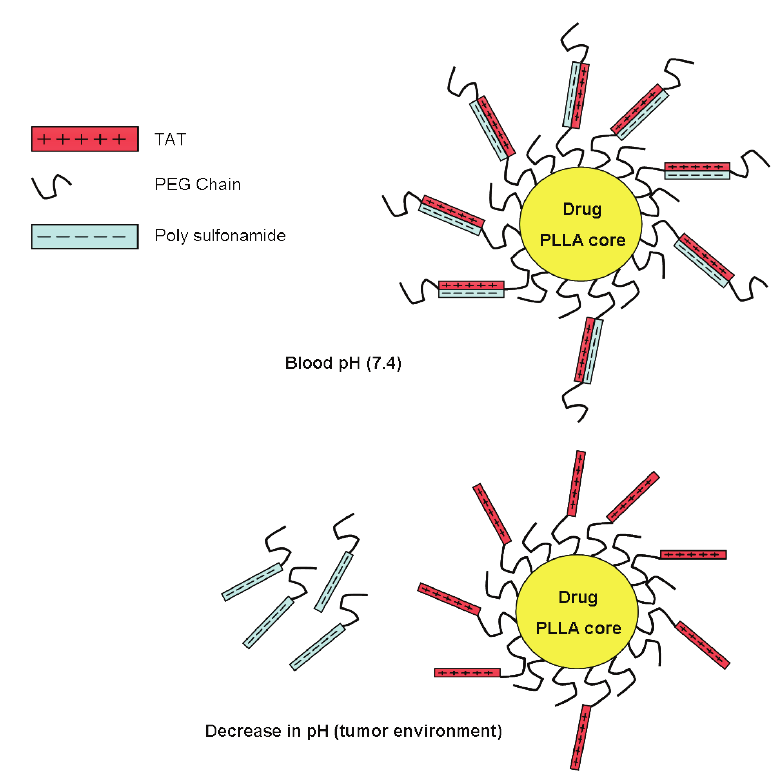
Figure 5. Schematic model for the drug delivery system proposed by Sethuraman and coworkers [133,134]. At pH 7.4 the sulfonamide is negatively charged, masking the positively charged TAT cell-penetrating peptide. But when the pH decreases in the vicinity of the tumor, the sulfonamide loses charge and detaches, thereby exposing TAT for interaction with the tumoral